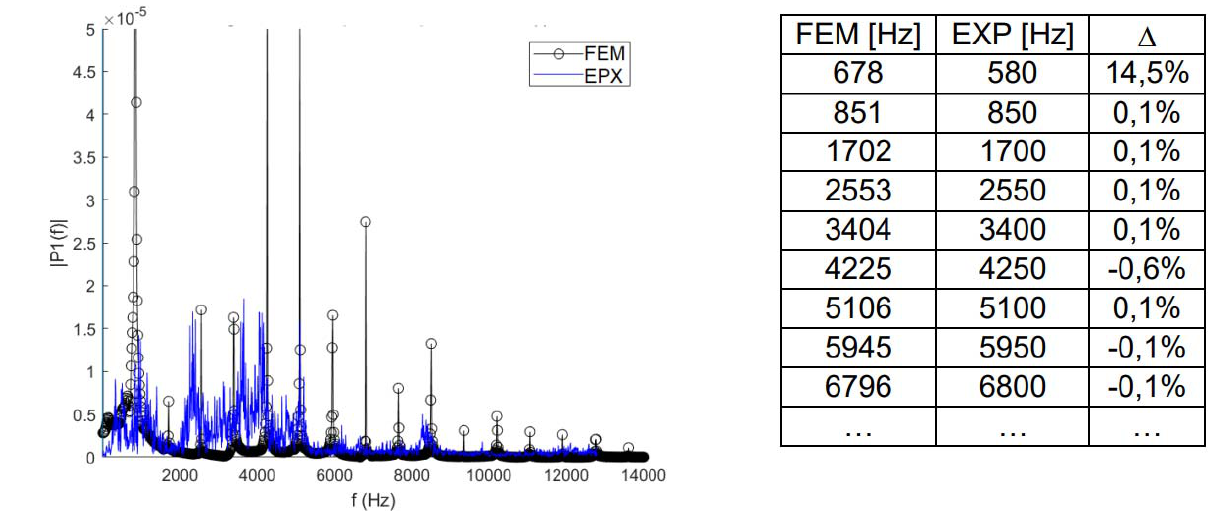
Figure 5. Comparison between the numerical and experimental data for the back-to-back test rig (housing).